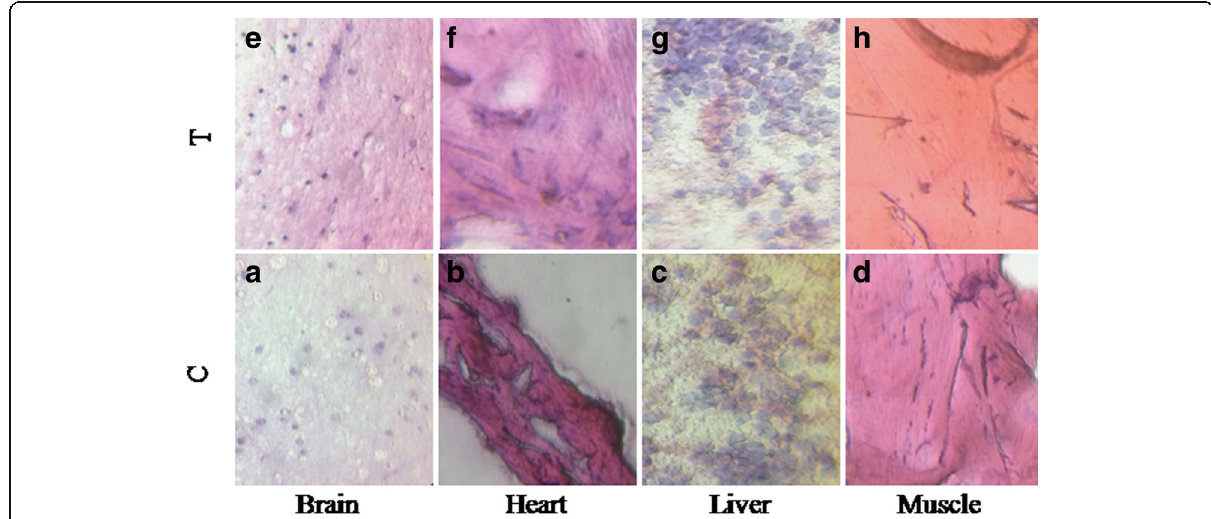
Fig. 6 In vivo chronic toxicology analysis. a , e Shows the unaltered brain pathology of control and GAE treated Zebrafish. b , f Shows the pathology of heart muscles in control and GAE treated Zebrafish. c , g Shows the unaltered muscle pathology of control and GAE treated Zebrafish. d , h Shows the pathology of liver cells in control and GAE treated Zebrafish. The pathology results confirm that GAE is not toxic to these major organs under chronic conditions. C-control,